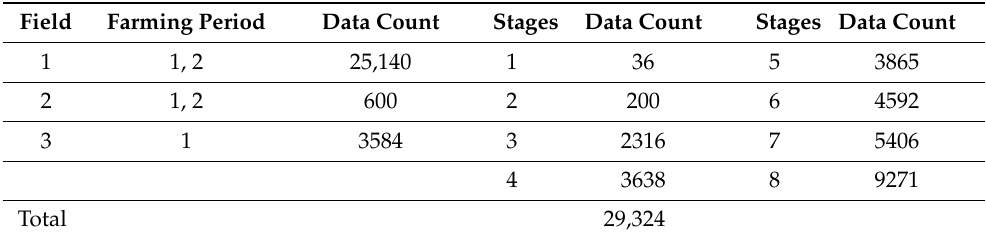
Table 3. Total data collected from three experimental fields and data count for each